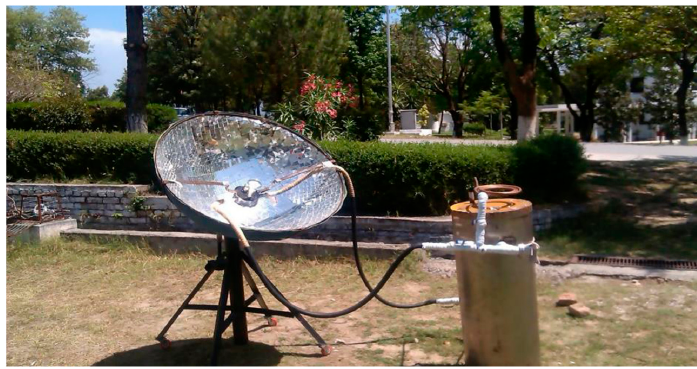
Figure 10. ( a ) Flow chart of charging PCM; ( b ) Flow chart of discharging PCM.